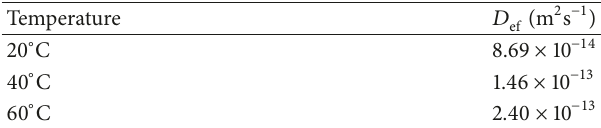
Figure6: Variationofresidualoilcontentasafunctionofextraction timeandtemperature(lines:fittomodel;points:experimentaldata). Table 2: Diffusion coefficients calculated for the test